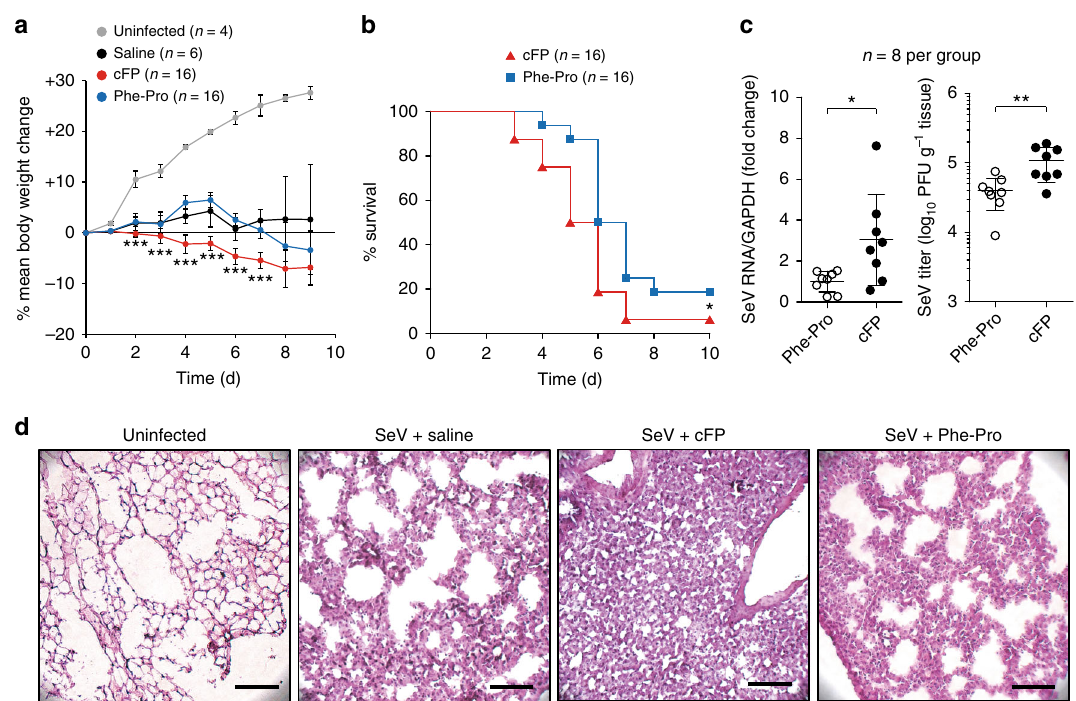
Fig. 7 Increase of mortality of Sendai virus-infected mice by cFP administration. DBA/2 mice (6-week-old male), which were given cFP or Phe-Pro (50 mg per kg body weight) by i.v. injection, were infected with Sendai virus (1,000 PFU) by intranasal injection 2 h after the dipeptide administration followed by two additional consecutive administrations at 1 and 2 days post-infection, prior to monitoring body weight change ( a ) and mouse mortality ( b ) over 10 days. Virus titers were determined by RT-qPCR (for RNA genome loads) and plaque-forming assays at 7 dpi ( c ). Shown in d are representative H&E stain images of lung sections at 7 dpi. Scale bar = 200 μ m. Statistical signi fi cance of differences between cFP-treated group and vehicle-treated, uninfected control group was determined via unpaired two-tailed t -test. Survival curves were analyzed using log rank (Mantel-Cox) test. * P < 0.05; ** P < 0.01, *** P <